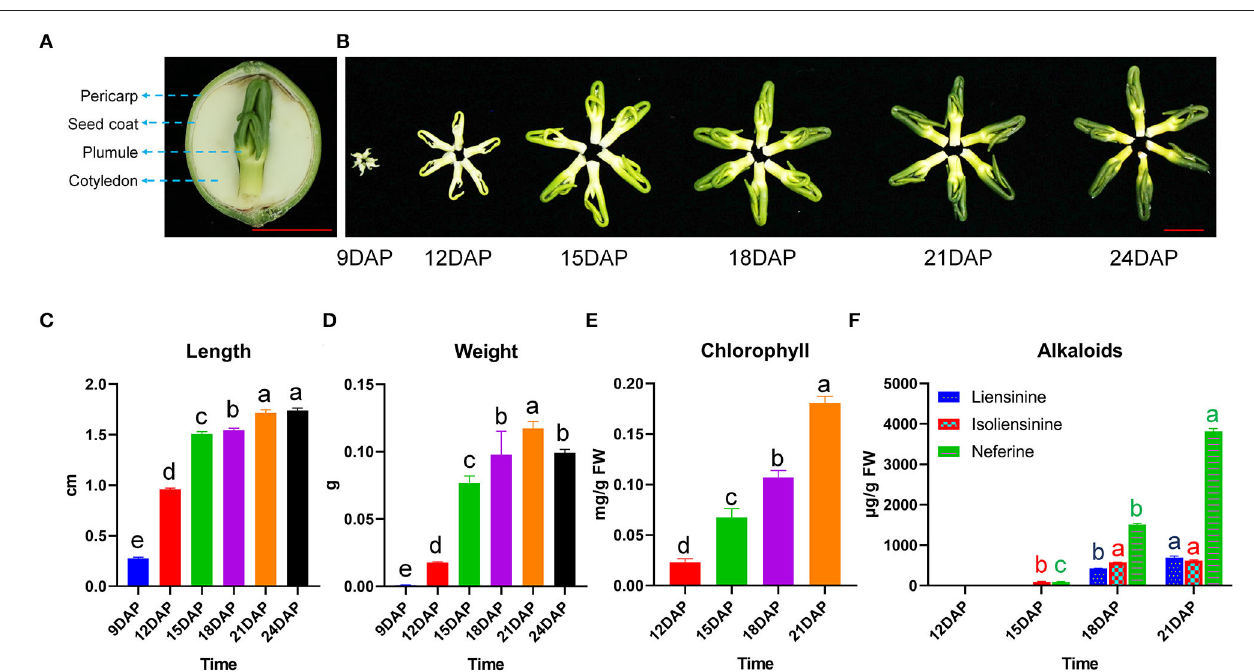
FIGURE 1 | Phenotypic changes during lotus plumule development in cv. “Jianxuan 17”. (A) The structure of lotus seed. (B) Morphological changes in lotus plumule during development. The red bars represent 1cm. (C) Length, and (D) Weight of lotus plumule at different developmental stages. Error bars represent means ± standard error ( n = 3). (E) Chlorophyll, and (F) Alkaloid contents in lotus plumule at different developmental stages. Error bars represent means ± standard error ( n = 4). Statistical significance is based on the Least Significant Difference (LSD) test at P < 0.05, one-way ANOVA. Different letters over bars indicate significant